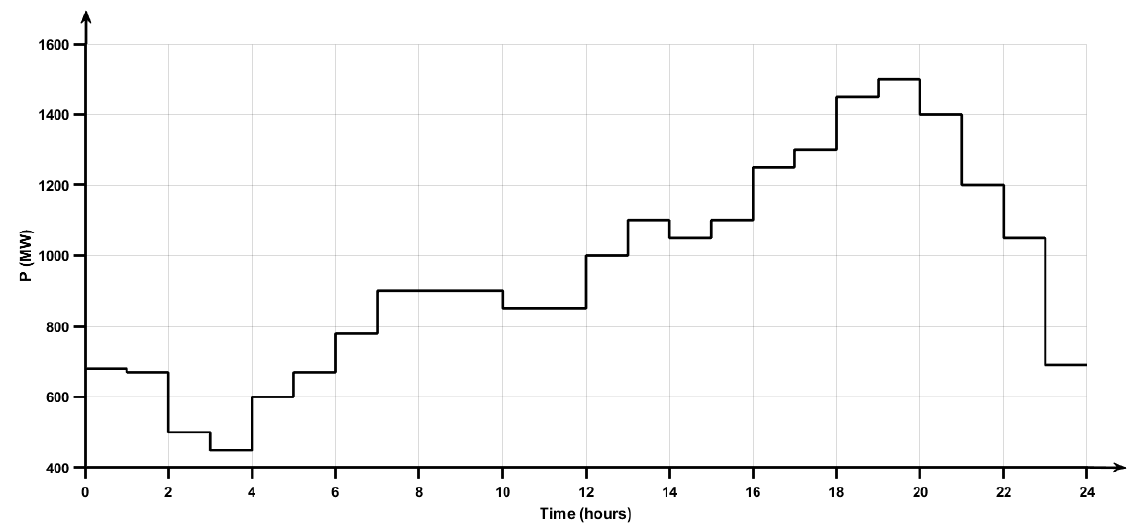
Figure 5. Load pa tt ern on network. Figure 5. Load pattern on